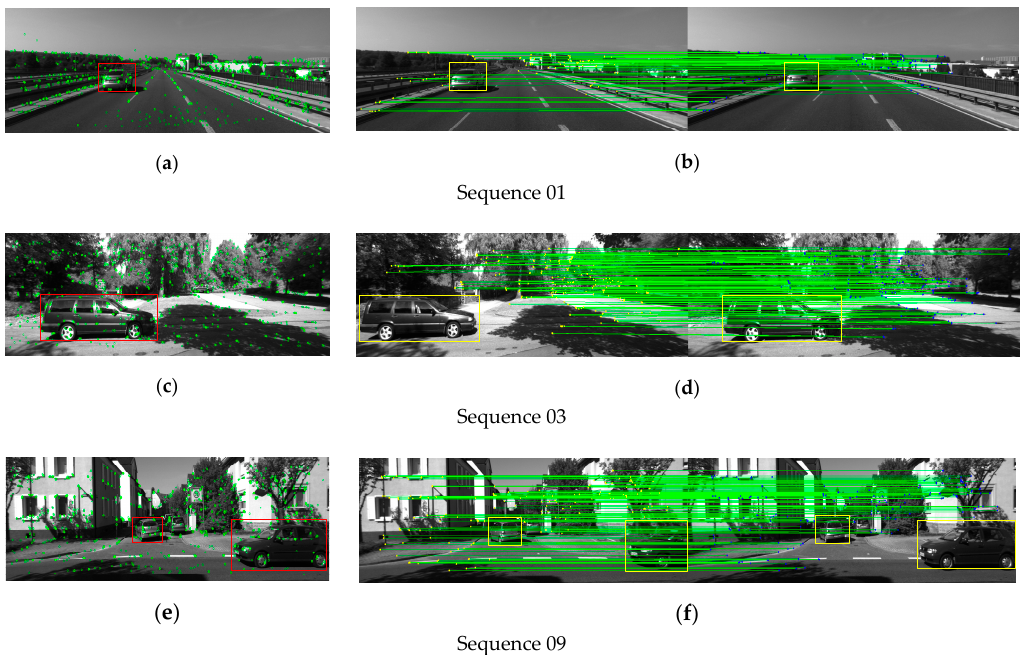
Figure 14. The DMS-SLAM extracts ( a , c , e ) and matches ( b , d , f ) experimental results of the ORB feature points on the 01, 03, 09 sequence in the KITTI datasets. The rectangular box represents the moving object in the scene, and the others are static areas.